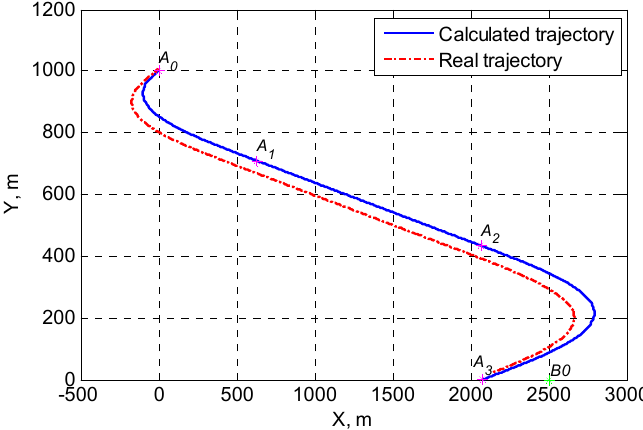
Figure 5. Projection of the space motion trajectory of the UAV in the vertical plane XY .